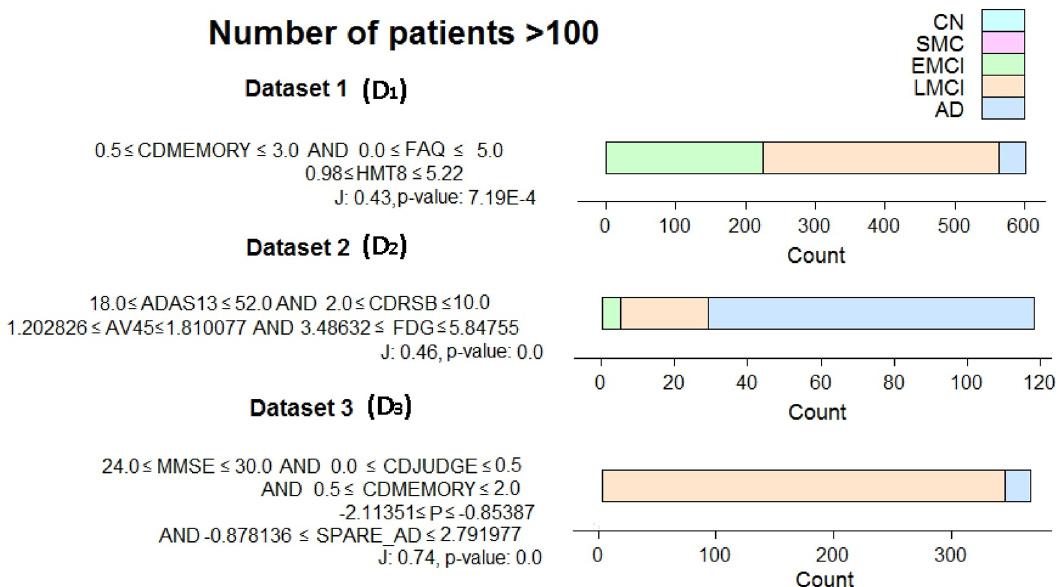
Fig 3. Example redescriptions (one for each dataset), each describing at least 100 subjects. All subjectsdescribed are diagnosedwith EMCI, LMCI or AD. Attribute explanations can be seen in Tables 2 and 3 (P denotesPAPP-A and FDG denotes